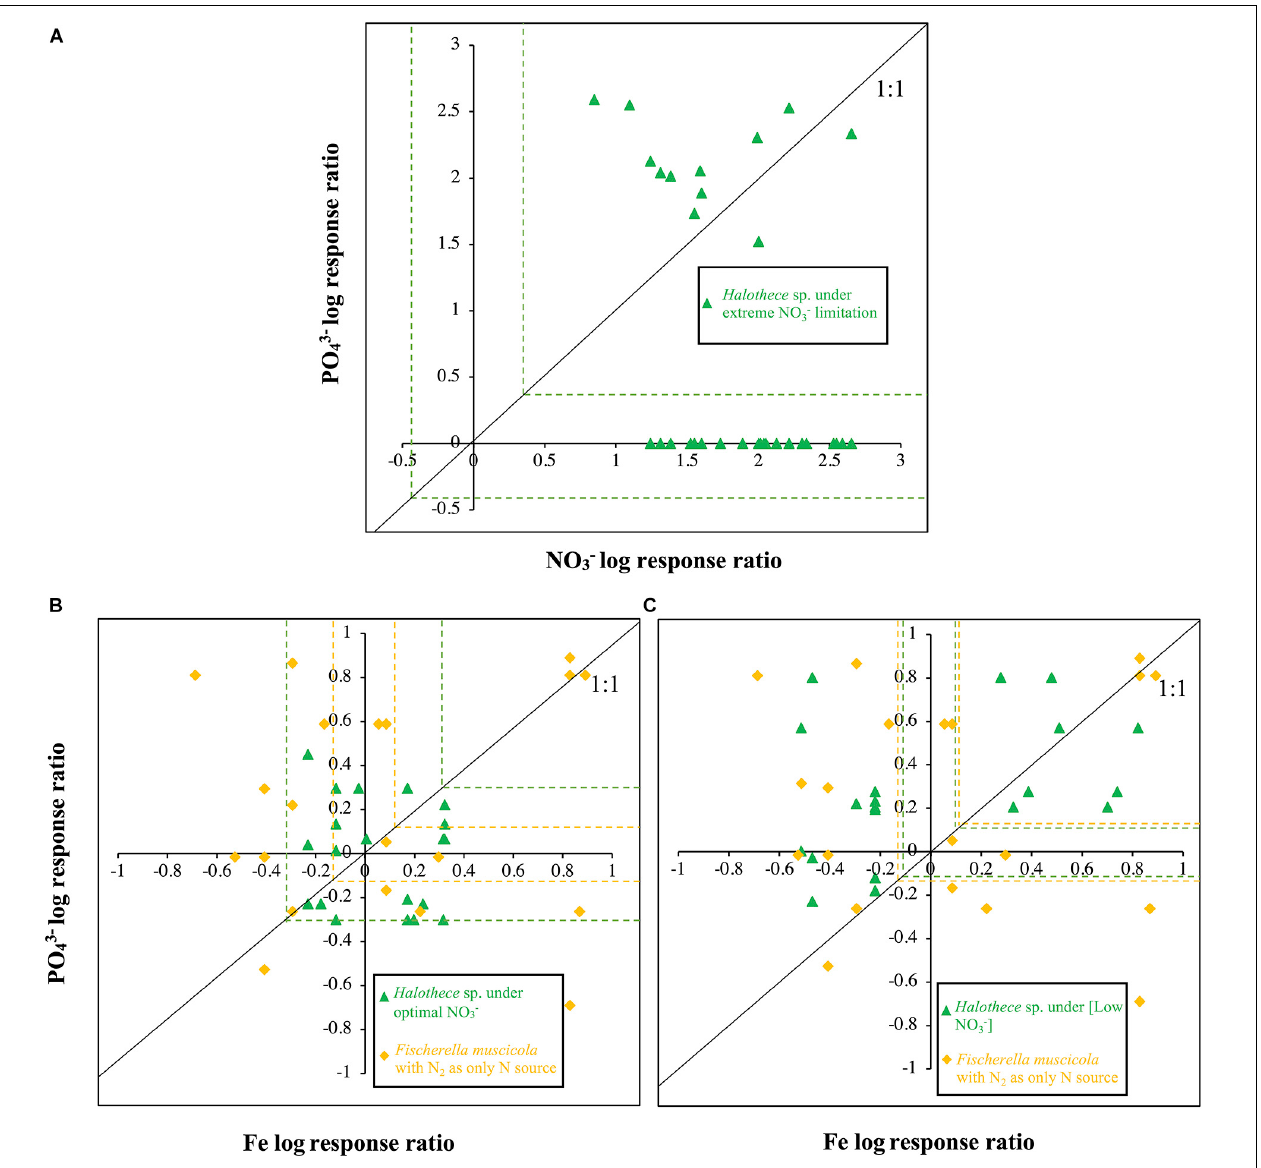
FIGURE 3 | Log nutrient responses for Halothece sp. and Fischerella muscicola . (A) PO 43 − and NO 3 − log response ratios for Halothece sp. (B) and (C) PO 43 − and Fe log response ratios for Halothece sp. (B) under optimal NO 3 − and (C) under [Low NO 3 − ] conditions and F. muscicola with N 2 as sole N source. Each data point represents each replicate in which X -axis is the NO 3 − or Fe log response and Y -axis is the PO 43 − log response. Dashed green (for Halothece sp.) and yellow lines (for F. muscicola ) represent the critical threshold values [data points outside the critical values are significantly different (at p = 0.05) from N 0 P 0 or Fe 0 P 0 ]. PO 43 − is represented as